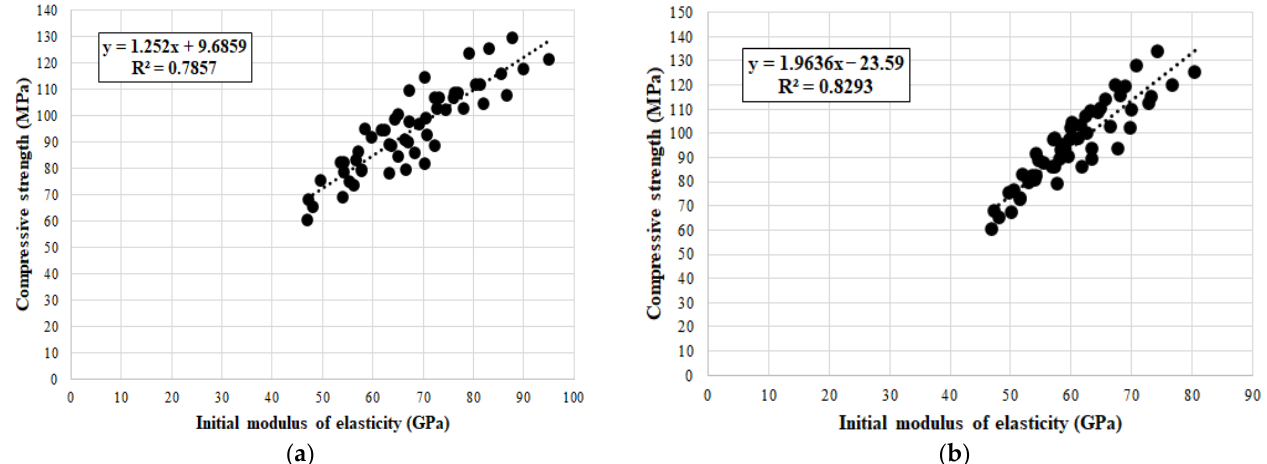
Figure 16. Effect of the fibres on the initial modulus of elasticity of HSC ( a ) SF and ( b ) PPF.